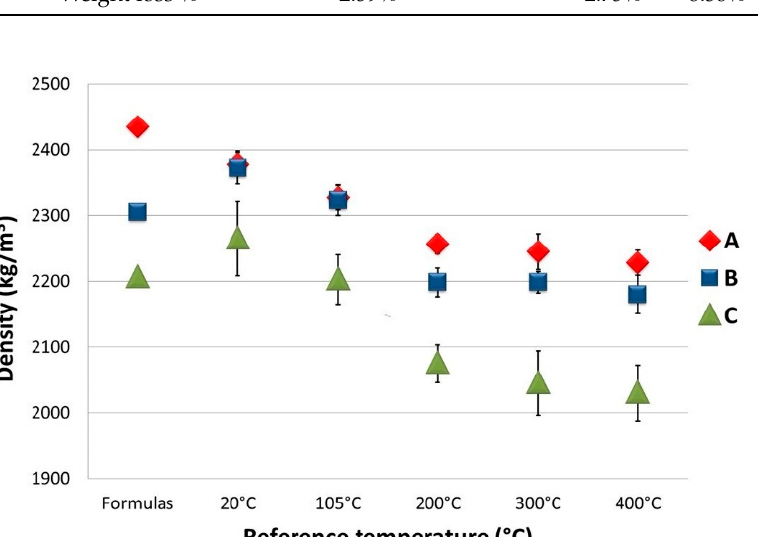
Figure 10. Density of the various mix designs for fresh and hardened concrete as a function of heat treatment temperature .